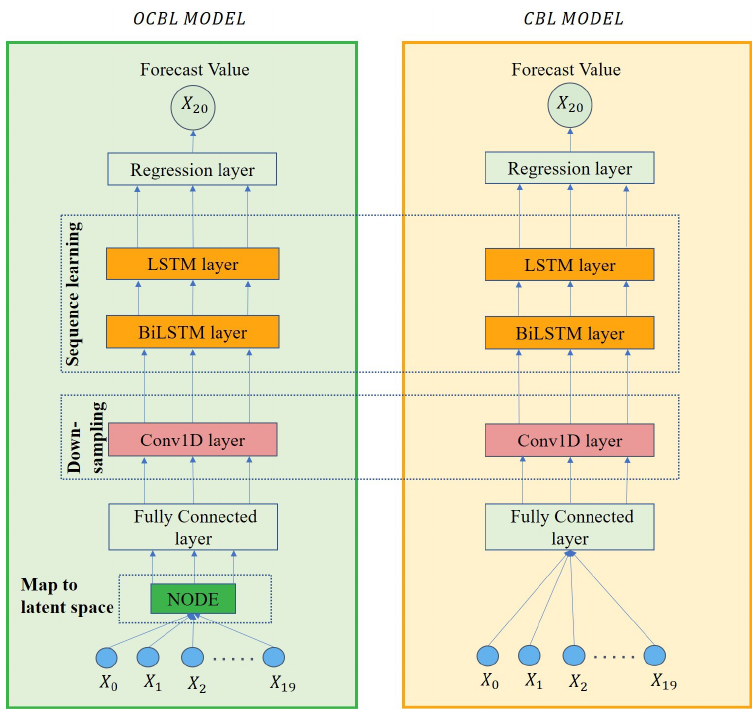
Figure 6. The model structures of OCBL and CBL. The second group of comparative models is ODE–BiLSTM–stacked LSTM (OBLL) and BiLSTM–stacked LSTM (BLL). BLL combines one BiLSTM layer and two LSTM layers, and OBLL adds an NODE layer in front of the BiLSTM layer. The model structures of OBLL and BLL are shown in Figure 7.